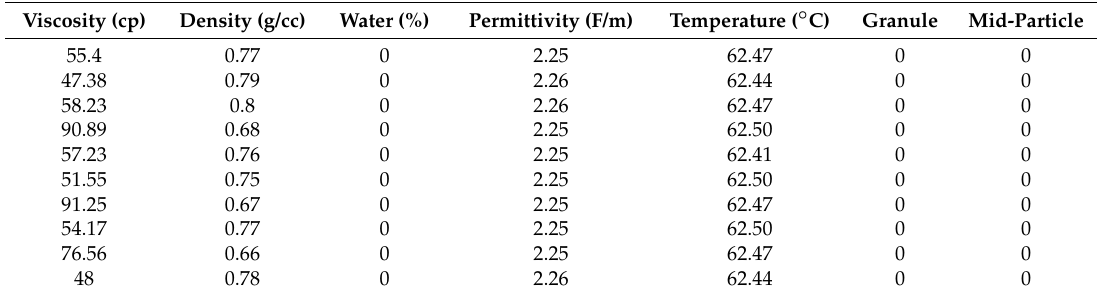
Table 3. Part of online oil monitoring data during normal wear of bearings.